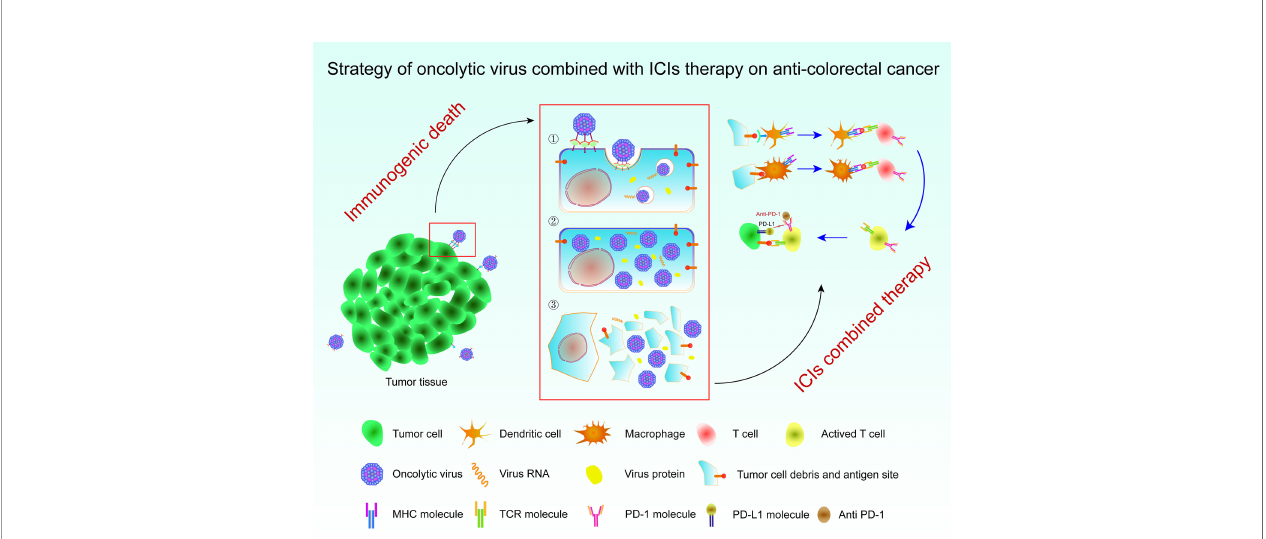
FIGURE 2 | Strategy of an oncolytic virus combined with ICI therapy for colorectal cancer. Immunogenic cell death occurs in tumor cells upon the action of oncolytic viruses, which release TAAs to activate APCs and then promote T cells to attack tumor cells. The combination of an oncolytic virus with ICIs removes the inhibition of T cells by tumor cells through the immune checkpoint. The tumor tissue is then removed to the maximum extent possible. ICI, immune checkpoint inhibitor; TAAs, tumor-associated antigens; APCs, antigen-presenting